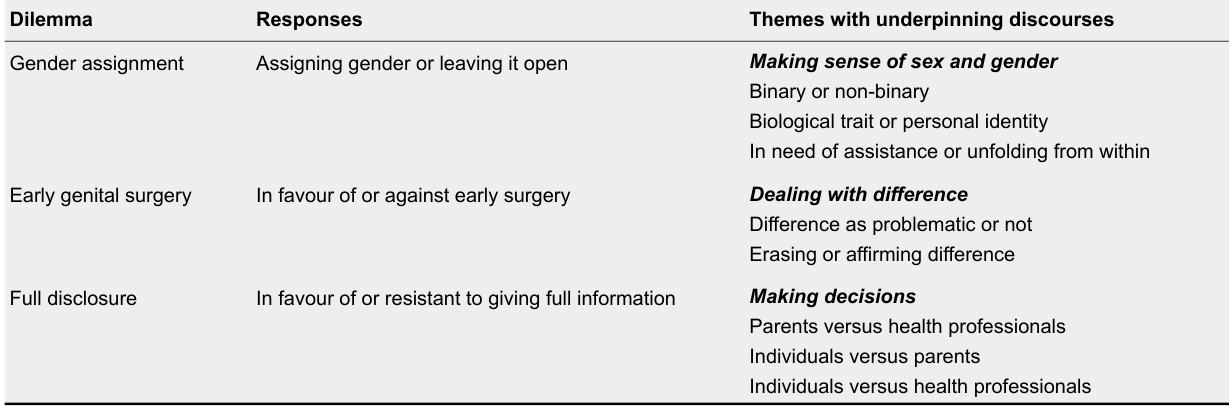
Summary of Dilemmas, Themes, and Underpinning Discourses